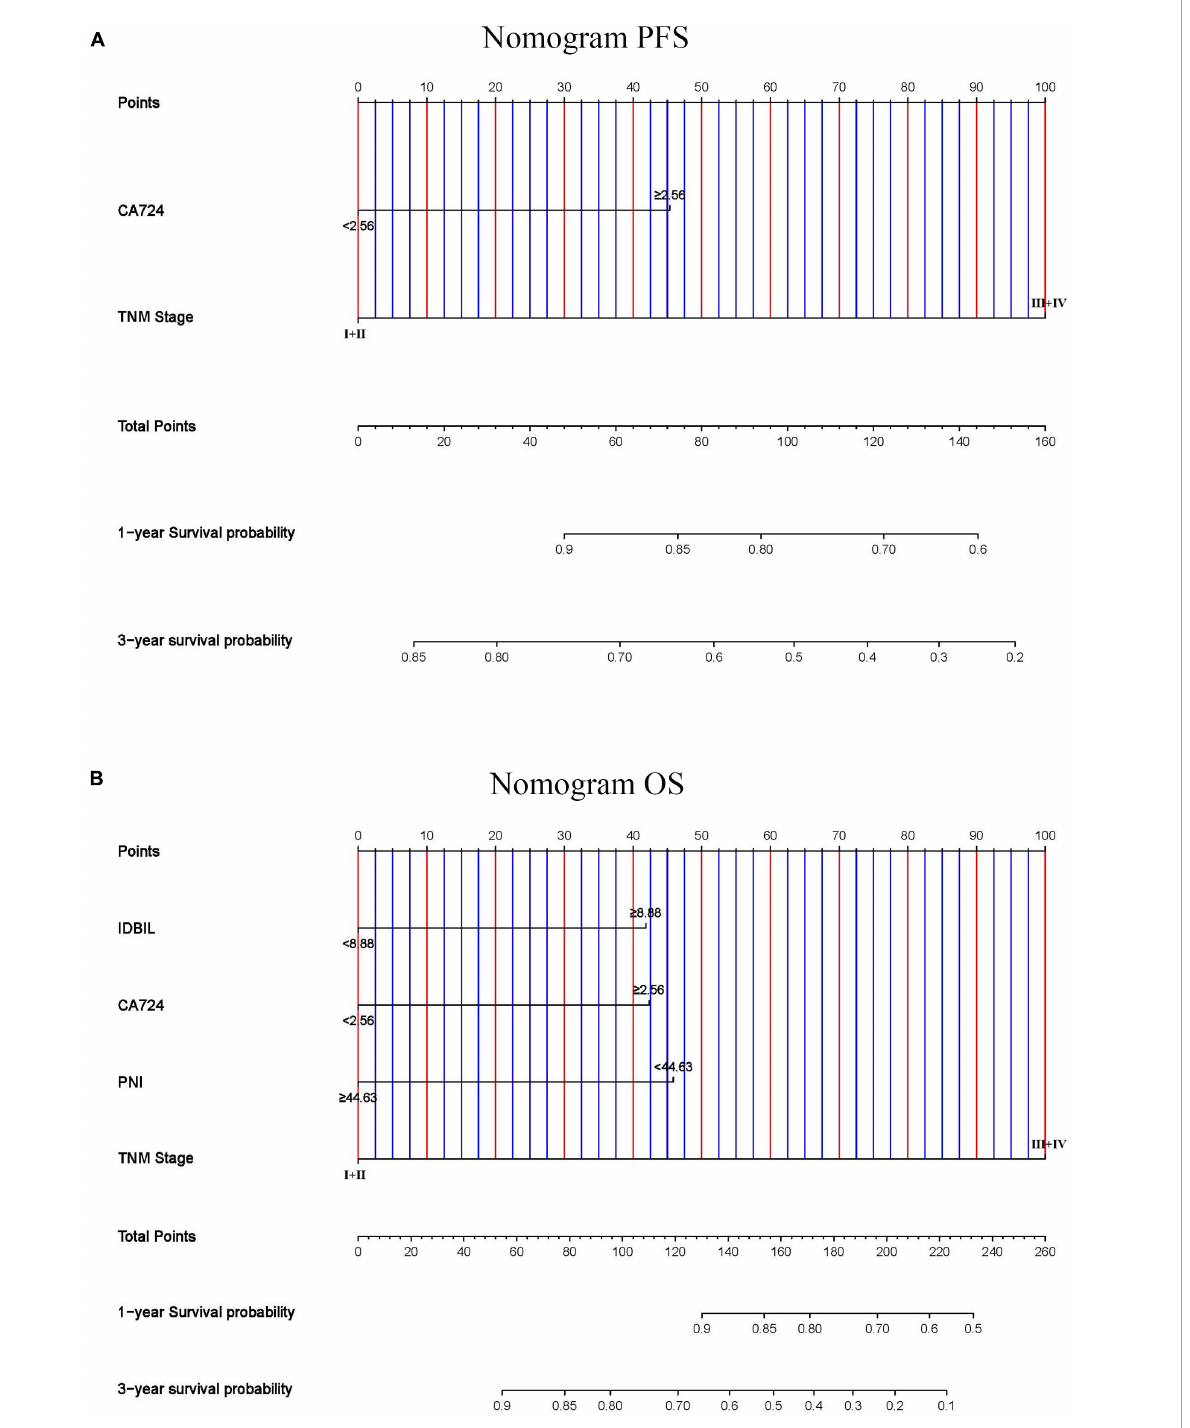
FIGURE8 Nomogram for predicting 1- and 3-year survival probabilities of (A) PFS and (B) OS.